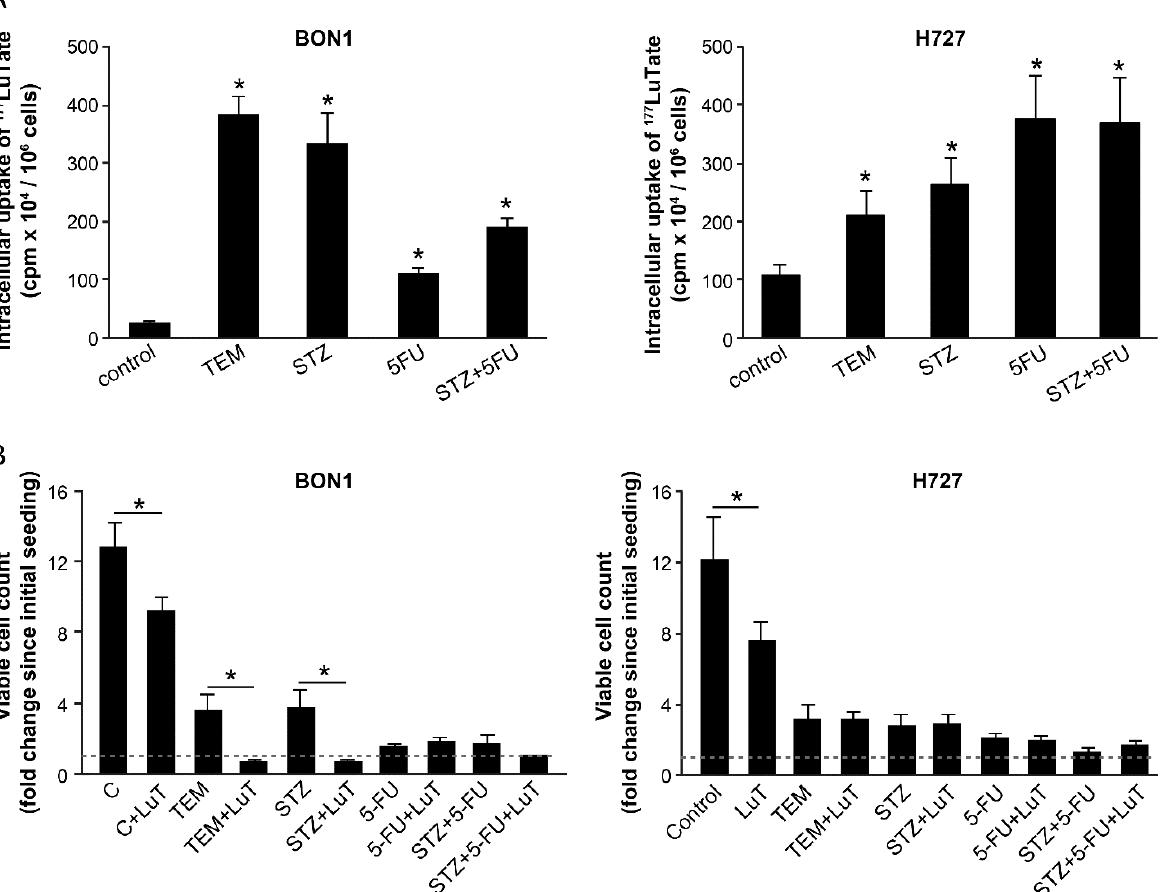
Figure 1. Co-administration with various chemotherapeutic drugs improves uptake of LuTate in BON-1 and NCI-H727 cells with more cytostatic effect in BON-1 cells. ( A ) Improved LuTate uptake after chemotherapy. BON-1 and NCI-H727 cells were treated for five days with LuTate alone or with 200 µM TEM, 25 µM 5-FU or 0.5 mg/mL STZ or a combination of 5-FU and STZ. The total cellular uptake of LuTate was measured on the 5th day. ( B ) A separate set of plates were treated for five days as described for panel A, washed, allowed to recover in fresh medium for 4 days prior to viable cell count, which is presented as fold increase over initial viable count, as indicated by dashed line at 1 on Y -axis. The data derived from two separate experiments, each with a minimum of triplicate independent dishes for each data point are represented as Mean ± SE (n = 6). The Student’s t-test was performed and * indicates significant difference with P value below 0.05 .